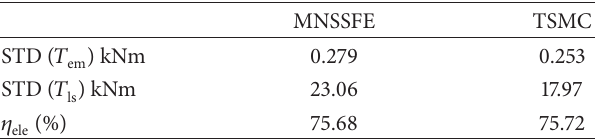
Table 6: Additive disturbance performance comparison for MNSSFE and TSMC.